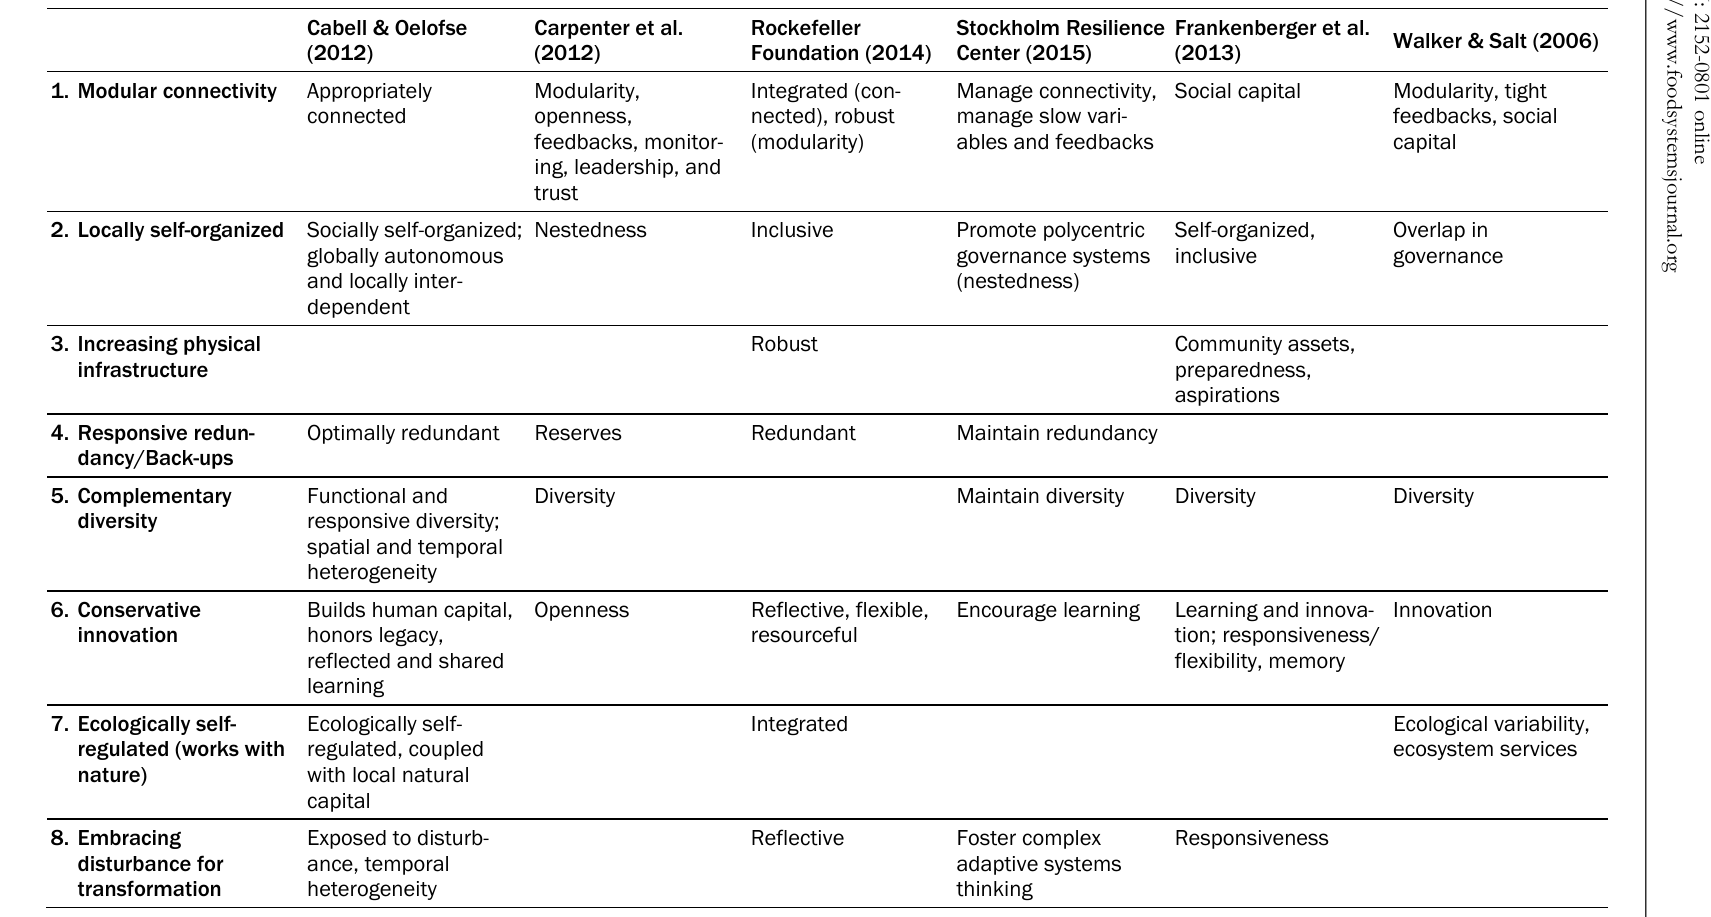
Table 1. Comparison of the Eight Qualities of Resilient Systems in Six Prominent Frameworks for Analysis of Resilient